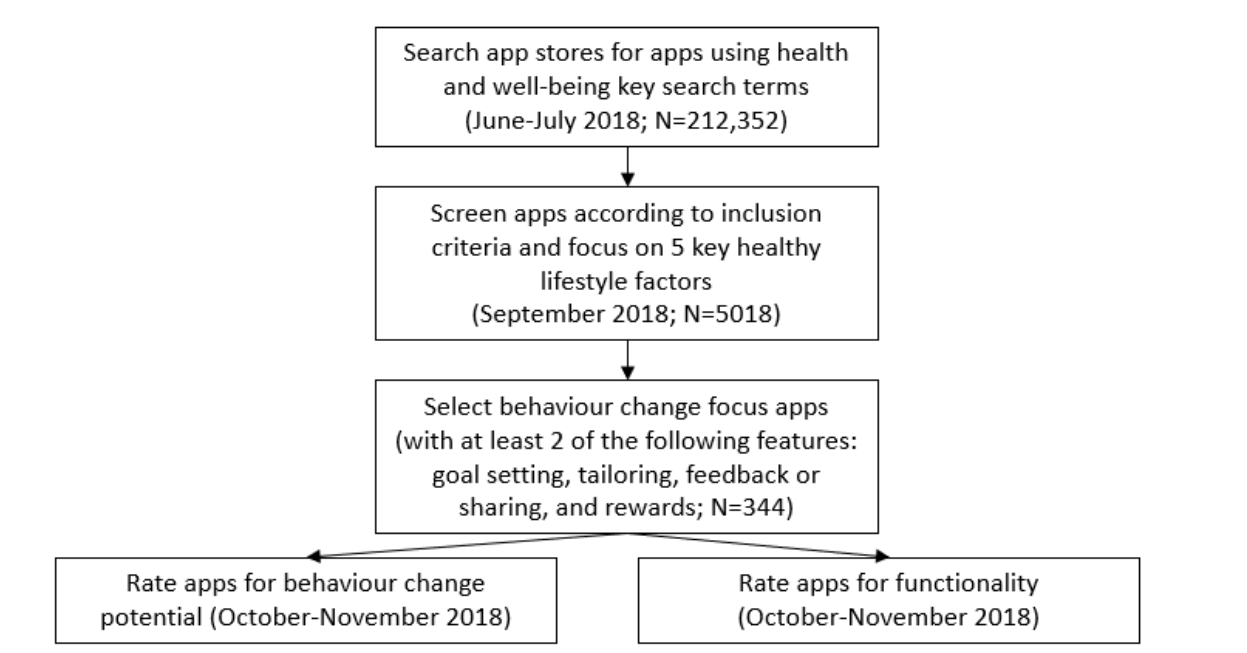
Figure 1. Process for identifying and rating